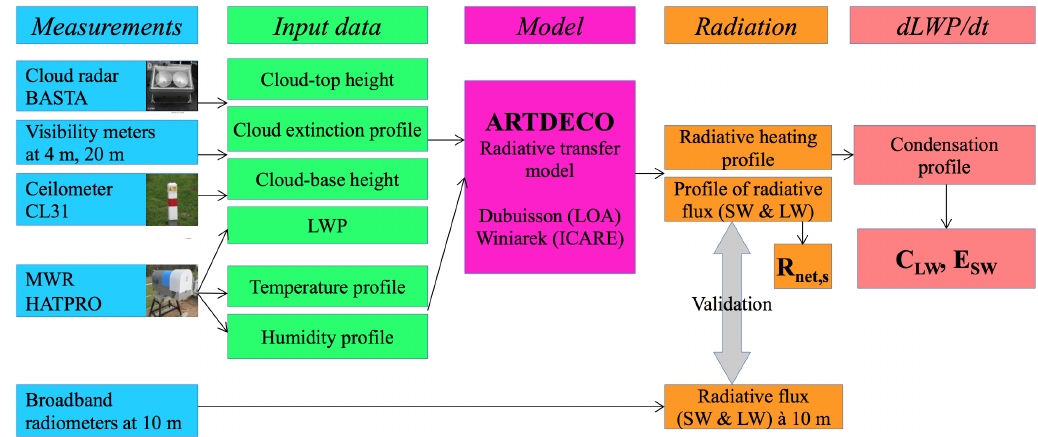
Figure 1. Schematic overview of the